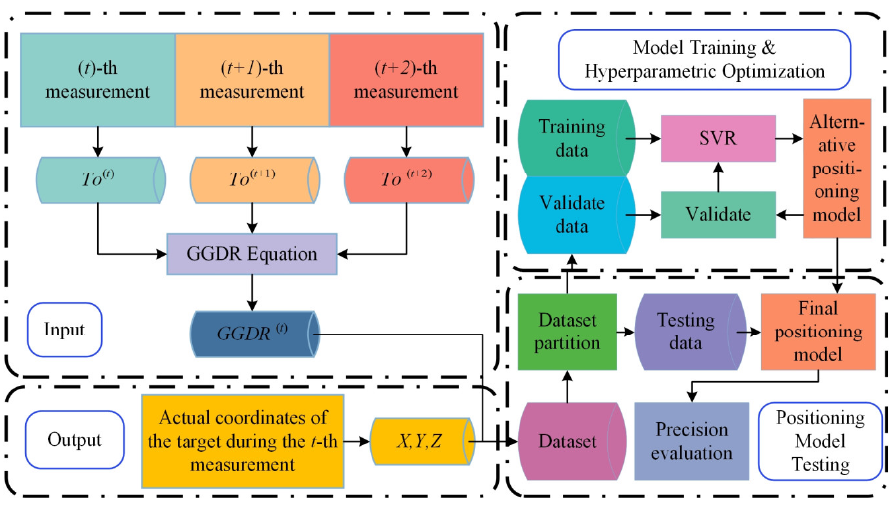
Figure 2. SGJM flow chart.